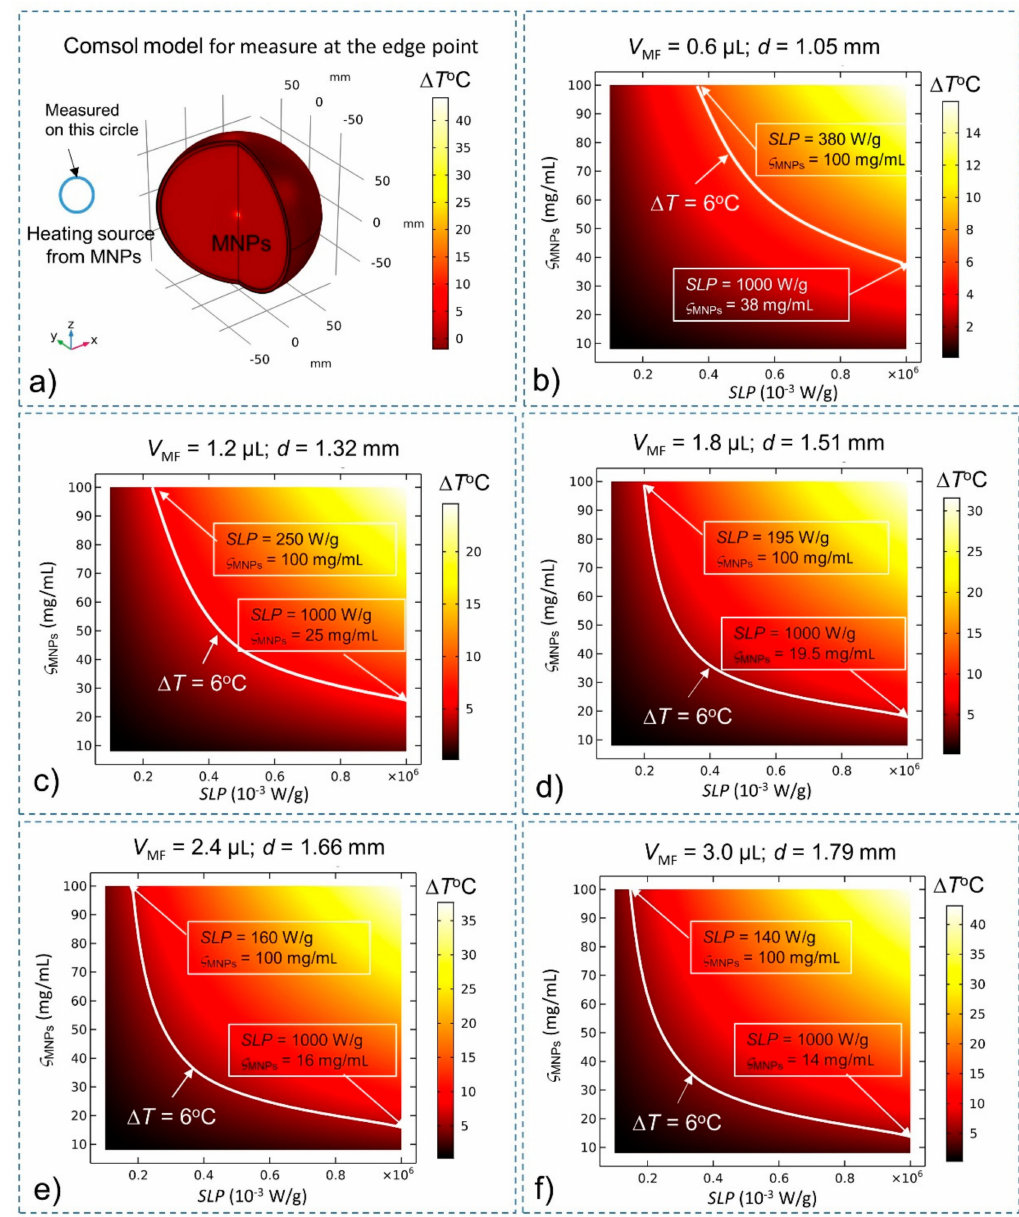
Figure 4. Steady-state temperature at the edge of the stimulation region while considering BF and CSF found using the bio-heat equation as a function of the SLP, concentration ( ς MNPs ) and volume ( V MF ) of MNPs. Conditions that satisfy the temperature increase ∆ T > 6 ◦ C lie above the white curve (which indicates the increase ∆ T = 6 ◦ C) ( a ) Comsol Multiphysics model for measuring temperature at the edge of the stimulation region; ( b ) V MF = 0.6 µ L; ( c ) V MF = 1.2 µ L; ( d ) V MF = 1.8 µ L; ( e ) V MF = 2.4 µ L; and ( f ) V MF = 3.0 µ